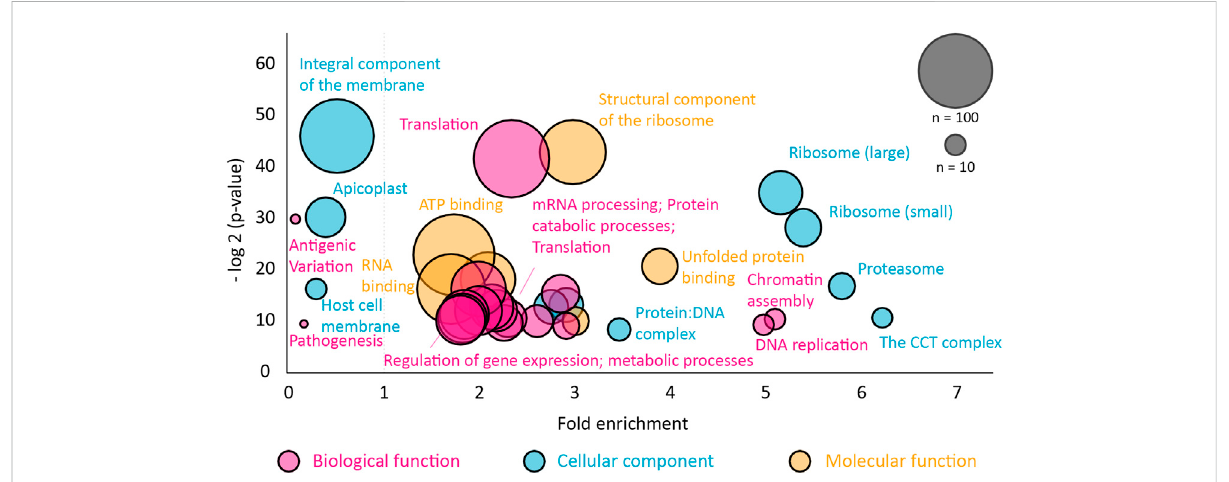
FIGURE 6 GeneontologyanalysisofthePfCCTinteractome.TheGeneOntology(GO)enrichmentanalysiswasperformedusingtheGOserverPANTHER for proteins that were more than two-fold enriched compared to the RNA polymerase pulldown. The full list with gene identi fi ers is provided in Supplementary Data S1. Node size corresponds to the number of proteins found in theclass, color represents GO class and enrichment is relativeto the P. falciparum proteome. The probability ( y -axis) is the probability of seeing at least x number of genes out of the total n genes in the list annotated to a particular GO term. Any class found below 1× fold enrichment is less than expected relative to the P. falciparum